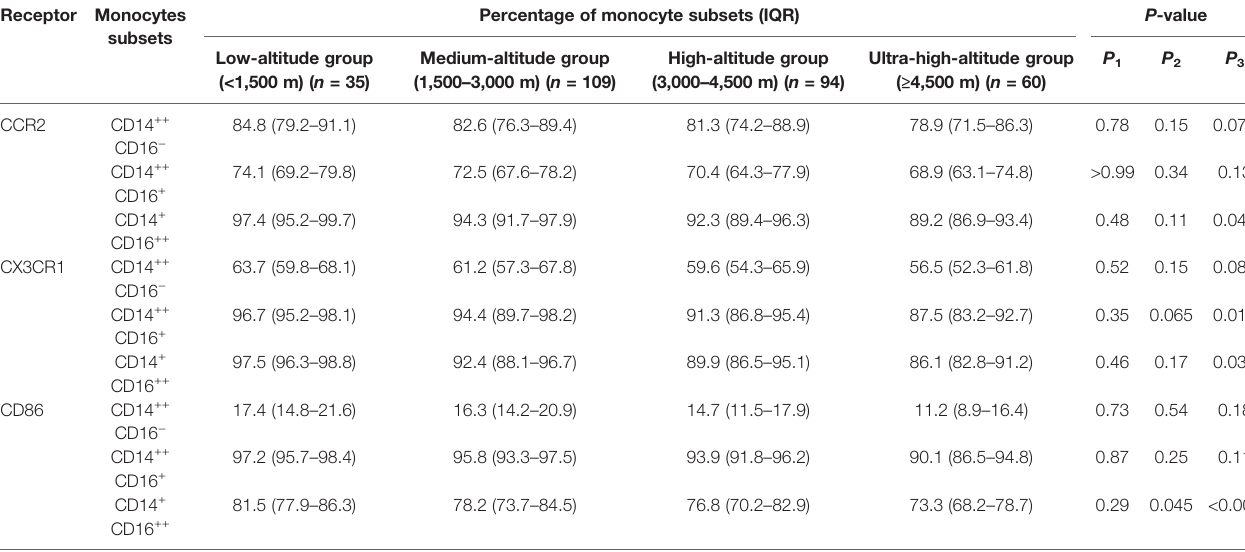
TABLE 2 | The receptor expression on the surface of monocyte subsets. Receptor Monocytes subsets